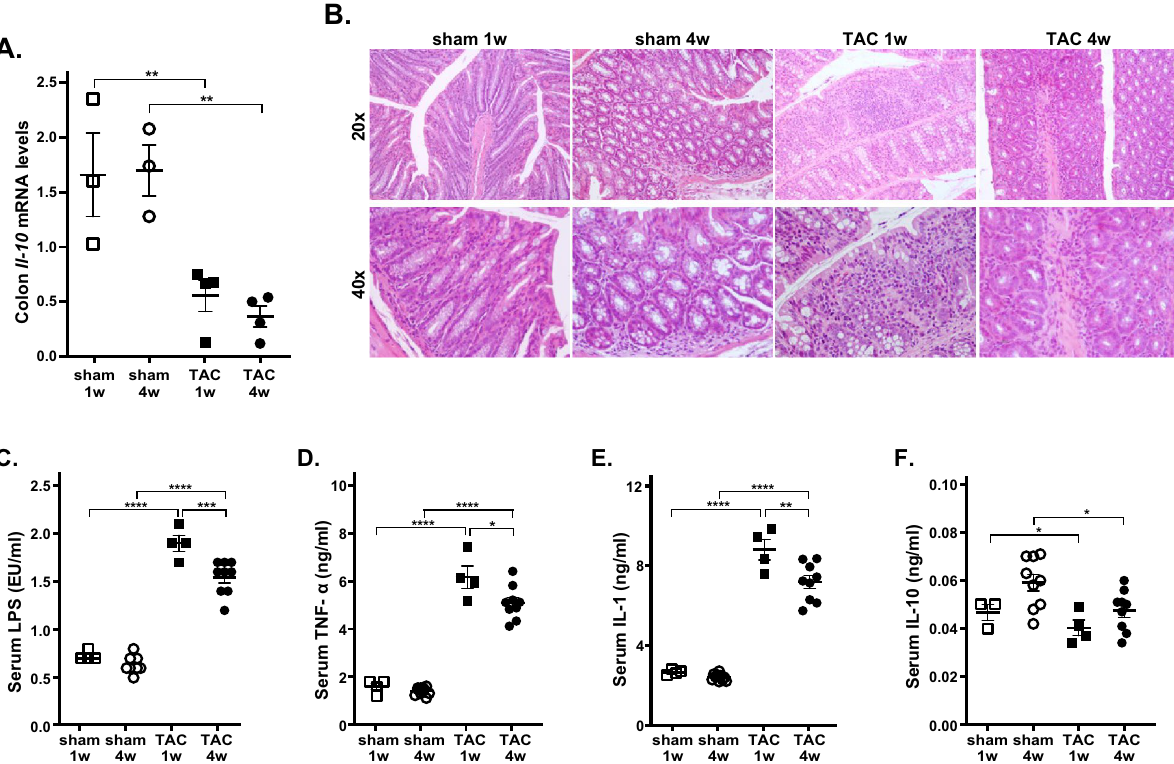
Figure 2. Effects of TAC or sham surgery on inflammation. ( A ) mRNA expression levels of Interleukin-10 ( Il10 ) in colon samples (sham: n = 3–4; TAC: n = 3–6). ( B ) Representative hematoxylin and eosin–stained sections from colon tissues of mice at original magnifications ×20 and ×40. Histological evaluation of inflammatory cells infiltration was scored along the entire colon length, inspecting the colon mucosa, submucosa and transmural areas considering the following parameters: (a) severity of inflammatory cell infiltration (sham 1w = 0.83 ± 0.16, sham 4w = 1.40 ± 0.24, TAC 1w = 2.25 ± 0.25, TAC 4w = 1.83 ± 0.31); (b) extent of the inflammation as expansion of leukocyte infiltration (sham 1w = 1.17 ± 0.31, sham 4w = 1.20 ± 20, TAC 1w = 2 ± 0, TAC 4w = 1.50 ± 0.22); and (c) presence of fibrosis (sham 1w = 0 ± 0, sham 4w = 0 ± 0,